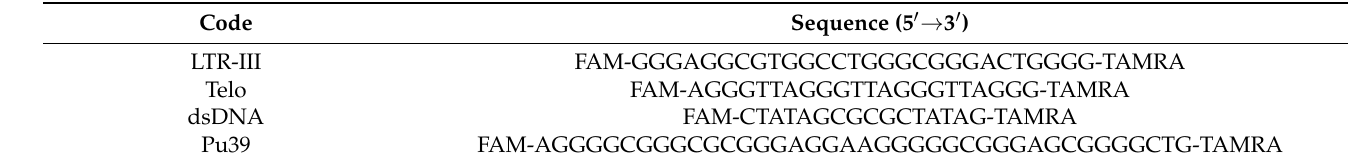
Table 1. ODNs, used in this